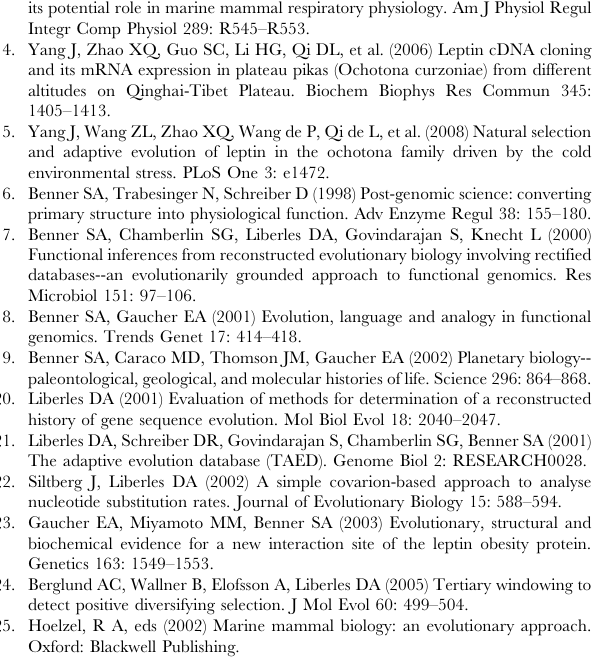
Figure S1 The mature protein alignment of 59 leptin sequences used in this study. The positions of four a -helices (helices A-D) and a distorted helix E in the CD loop are indicated. The species in Cetacea and Pinnipedia are crossed. Figure S2 The mature protein alignment of 24 leptin receptor ( LPR ) sequences used in this study. The positions of extracellular, transmembrane, and intracellular regions, as well as the binding regions for leptin (cytokine receptor homology; CRH2) are indicated. The species in Cetacea and Pinnipedia are crossed. Figure S3 NJ trees based on leptin alignment (501 nt; 59 sequences). MP and Bayesian analyses (AIC model: GTR + G; Base frequencies: A=0.2405; C=0.3097; G=0.2365 and T=0.2133;